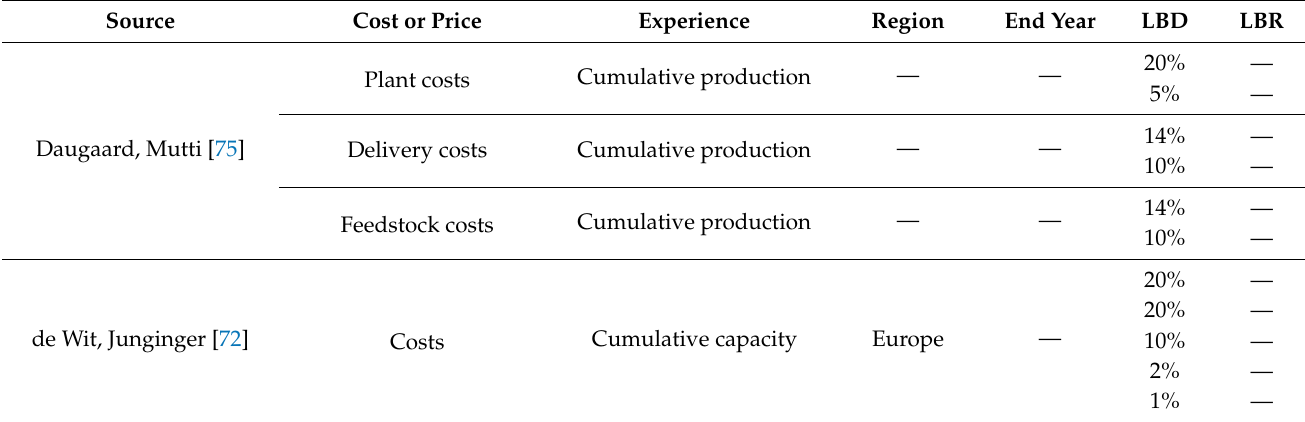
Table A3. LRs for biofuel plants.